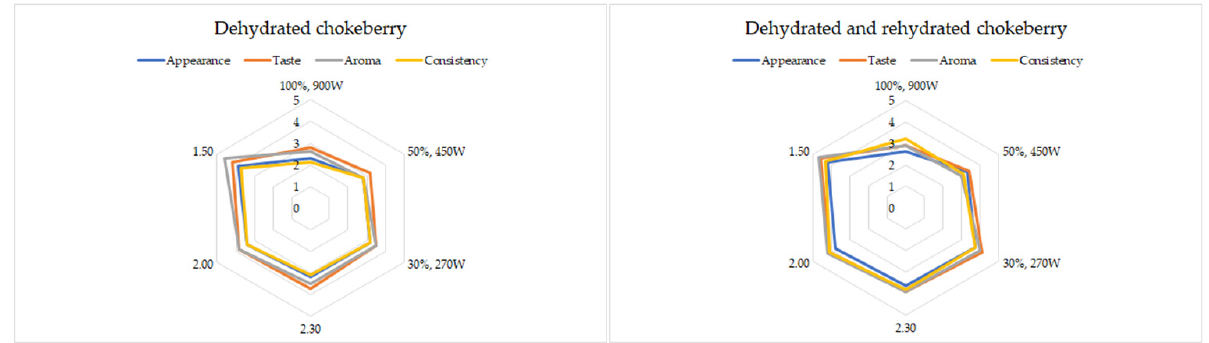
Figure 4. Sensory evaluation of dehydrated and dehydrated/rehydrated chokeberries.